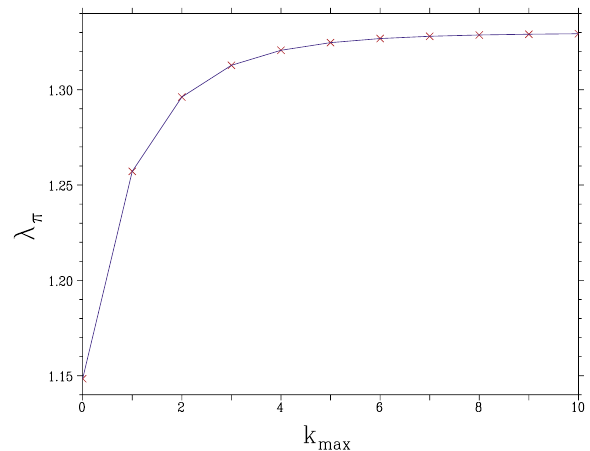
FIG. 5. (Color) The first p -mode eigenvalue for R (cid:1) 0 as a function of the truncation of Hermitian expansion.